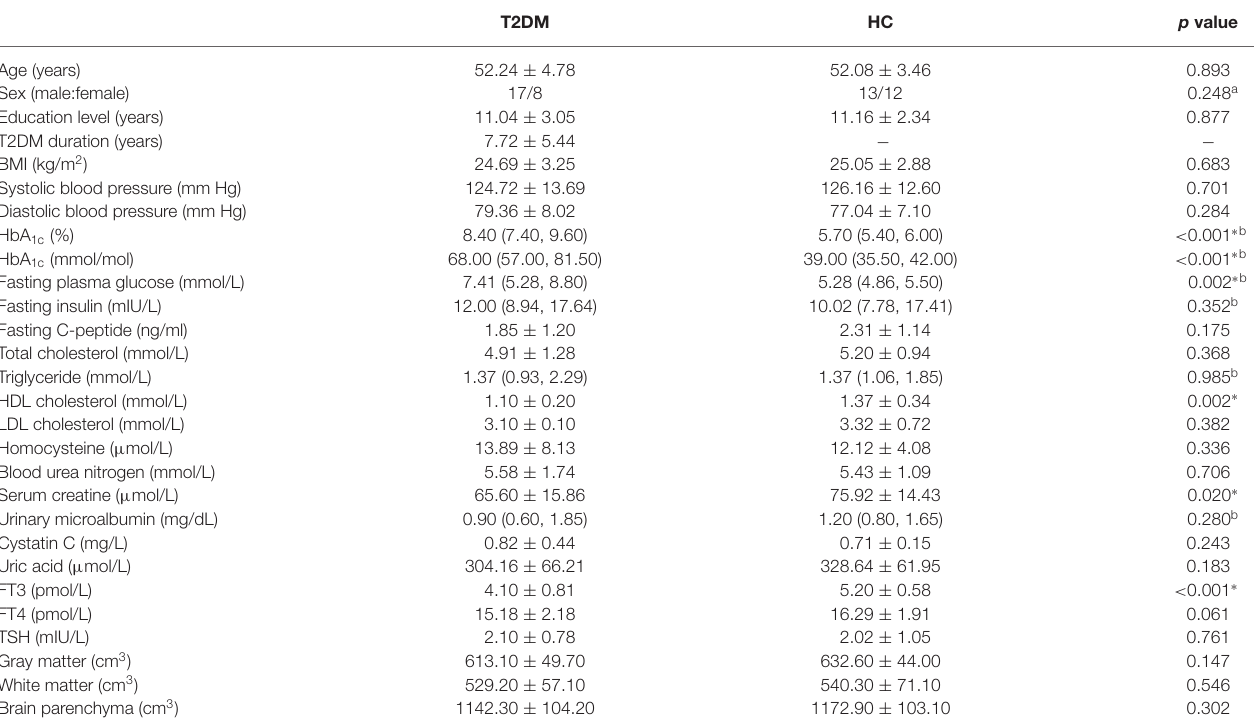
TABLE 1 | Demographic and clinical data comparison results of T2DM patients and healthy